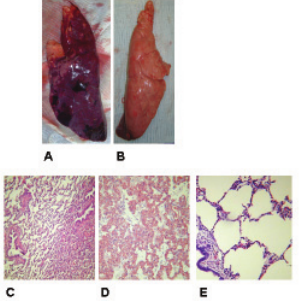
Figure 2 - Gross specimens of lung from septic (A) and control animals (B). Representative lung histology depicting collapse (C) and pulmonary hemorrhage (D) in septic pigs and normal pulmonary parenchyma in control animals